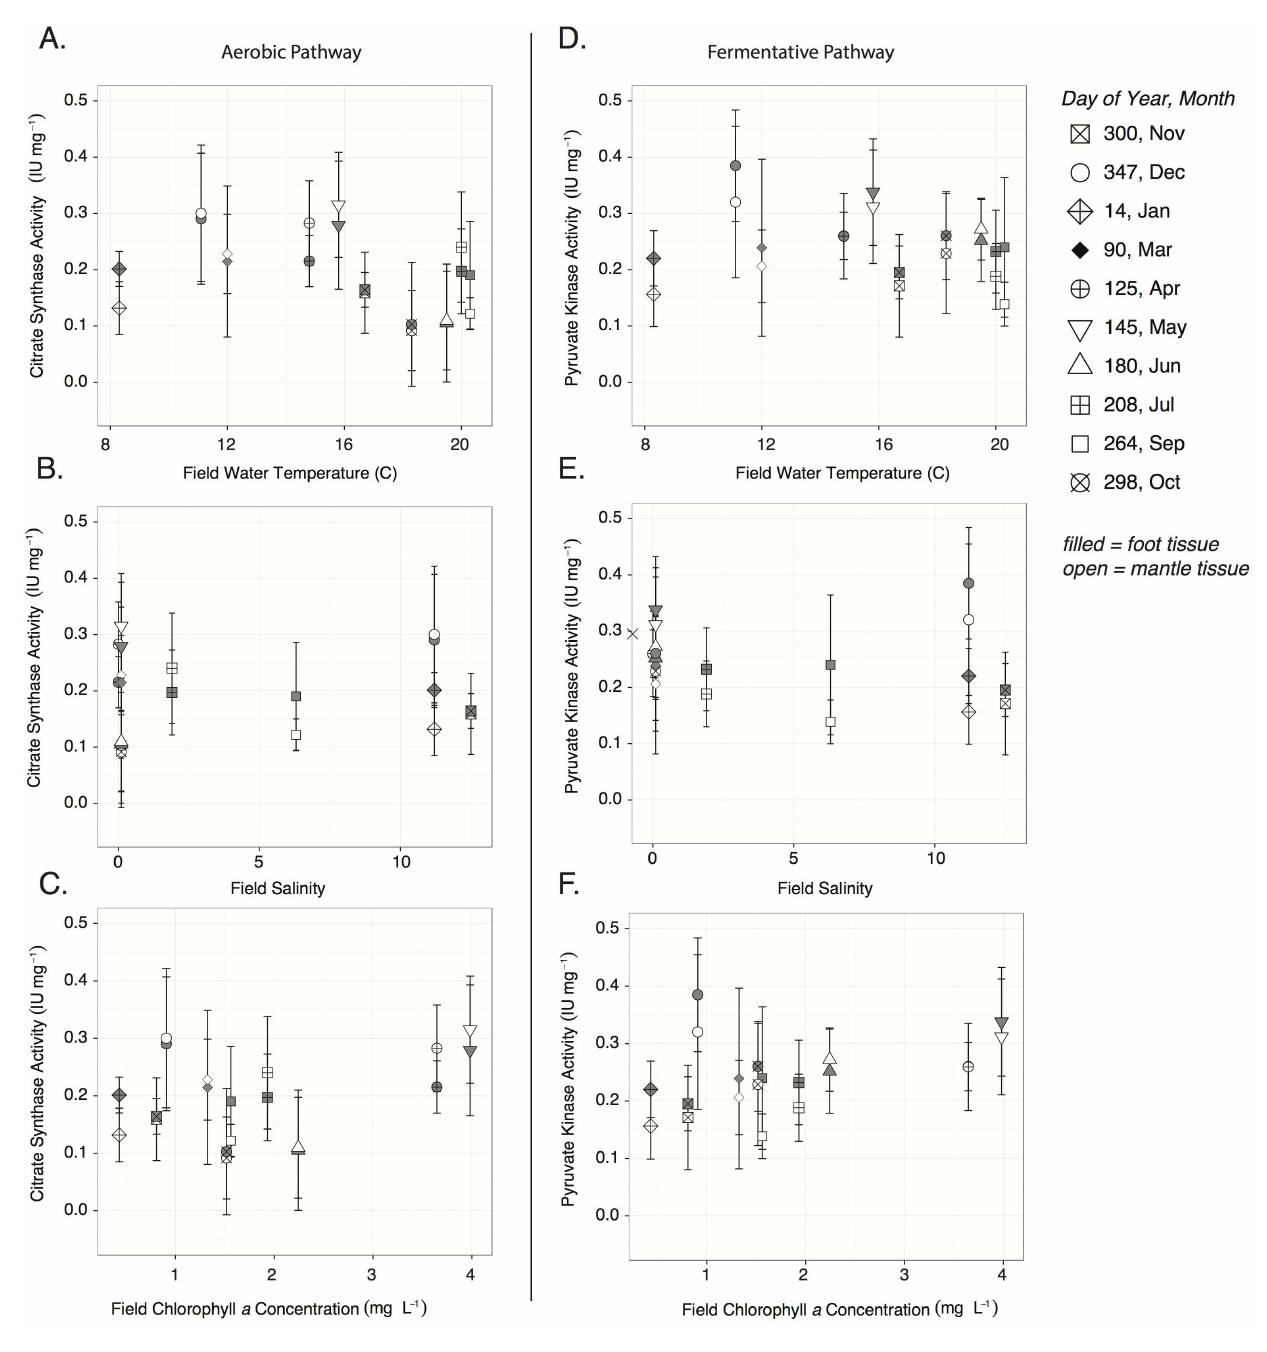
Figure 1. Enzyme activities in field collected clams. Citrate synthase ( A, B, C ) and pyruvate kinase ( D, E, F ) activity (IU mg wet tissue 2 1 ) in clam mantle and foot tissue, as a function of field temperature ( u C), salinity, and chlorophyll a concentration (mg L 2 1 ) for field sampling dates from Nov 2010-Oct 2011. Citrate synthase represents the potential for aerobic metabolic pathways, while times when pyruvate kinase activity exceeds that of citrate synthase represent the potential for fermentative pathways to predominate. Values represent means, n=6. doi:10.1371/journal.pone.0091064.g001 model (lowest AIC) explaining the PK:CS ratio included a two- effect of food was statistically significant (Linear regression: way interaction between salinity and food (Table 1B) and the main F 1,109 = 13.32, p , 0.001). effects of salinity and food. The interaction was non-significant Mantle CS and PK activities in the 30-day acclimation (Linear regression: F 2,66 = 2.17, p= 0.12) though there was a main experiment are strongly correlated (Figure 2B) (Pearson correla- effect of salinity (Linear regression: F 2,66 =5.13, p , 0.01 and the tion: 0.69, t df=70 = 7.94, p , 0.001). PK activity exceeded CS adjusted R 2 for the model was 0.12. activity in most treatments except for treatment 1 (salinity: 2, temperature: 12, food level: High). The best linear regression